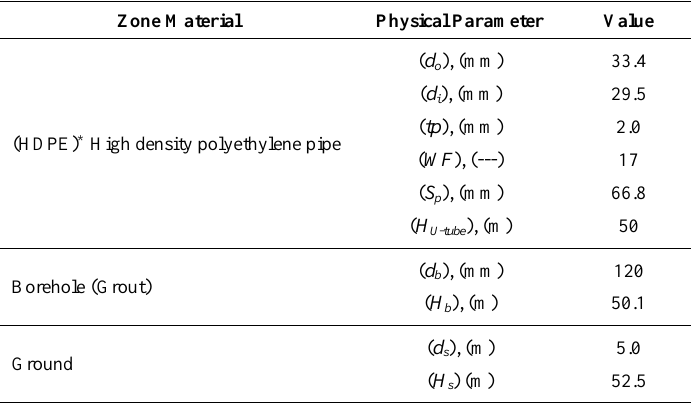
Table 2. Physical dimensions of different zones.